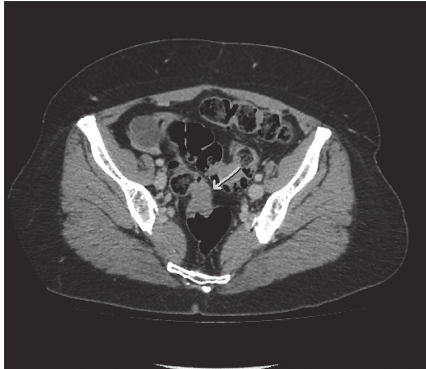
Figure 1: Abdomen tomography with stenosing lesions in the upper rectum and sigmoid presenting impregnation with contrast, as shown by the pointing arrow.